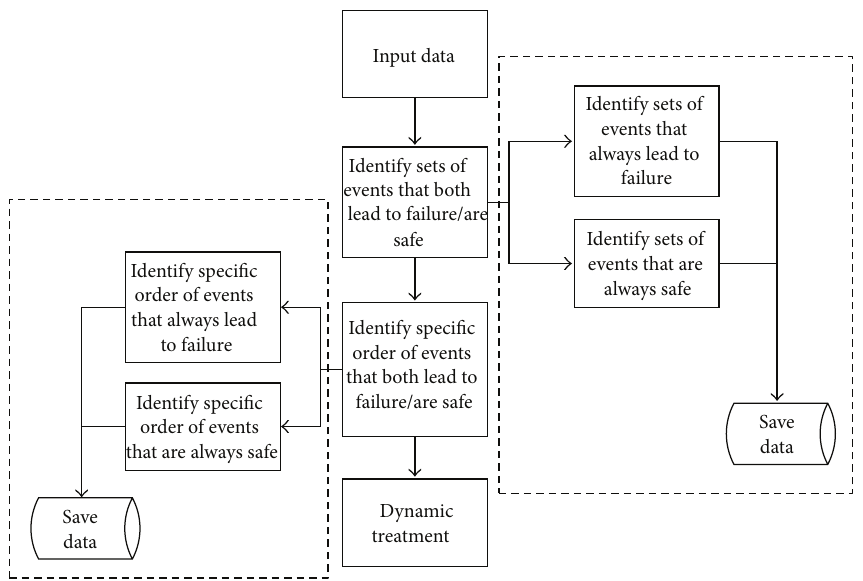
Figure 2: Scenario grouping